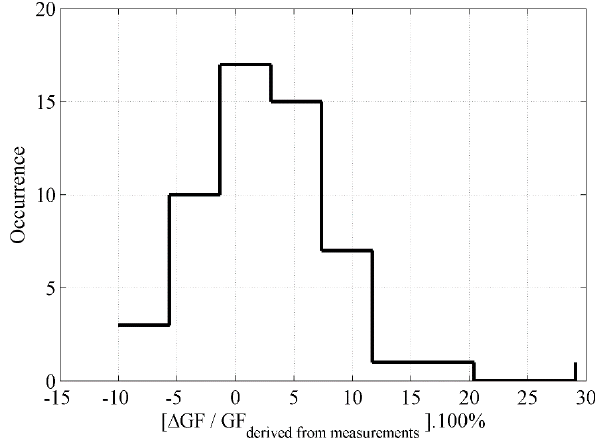
Figure 7. Histogram of modeled growth factor deviations from val- ues derived from the humidified nephelometer measurements in per- centage (%) during the